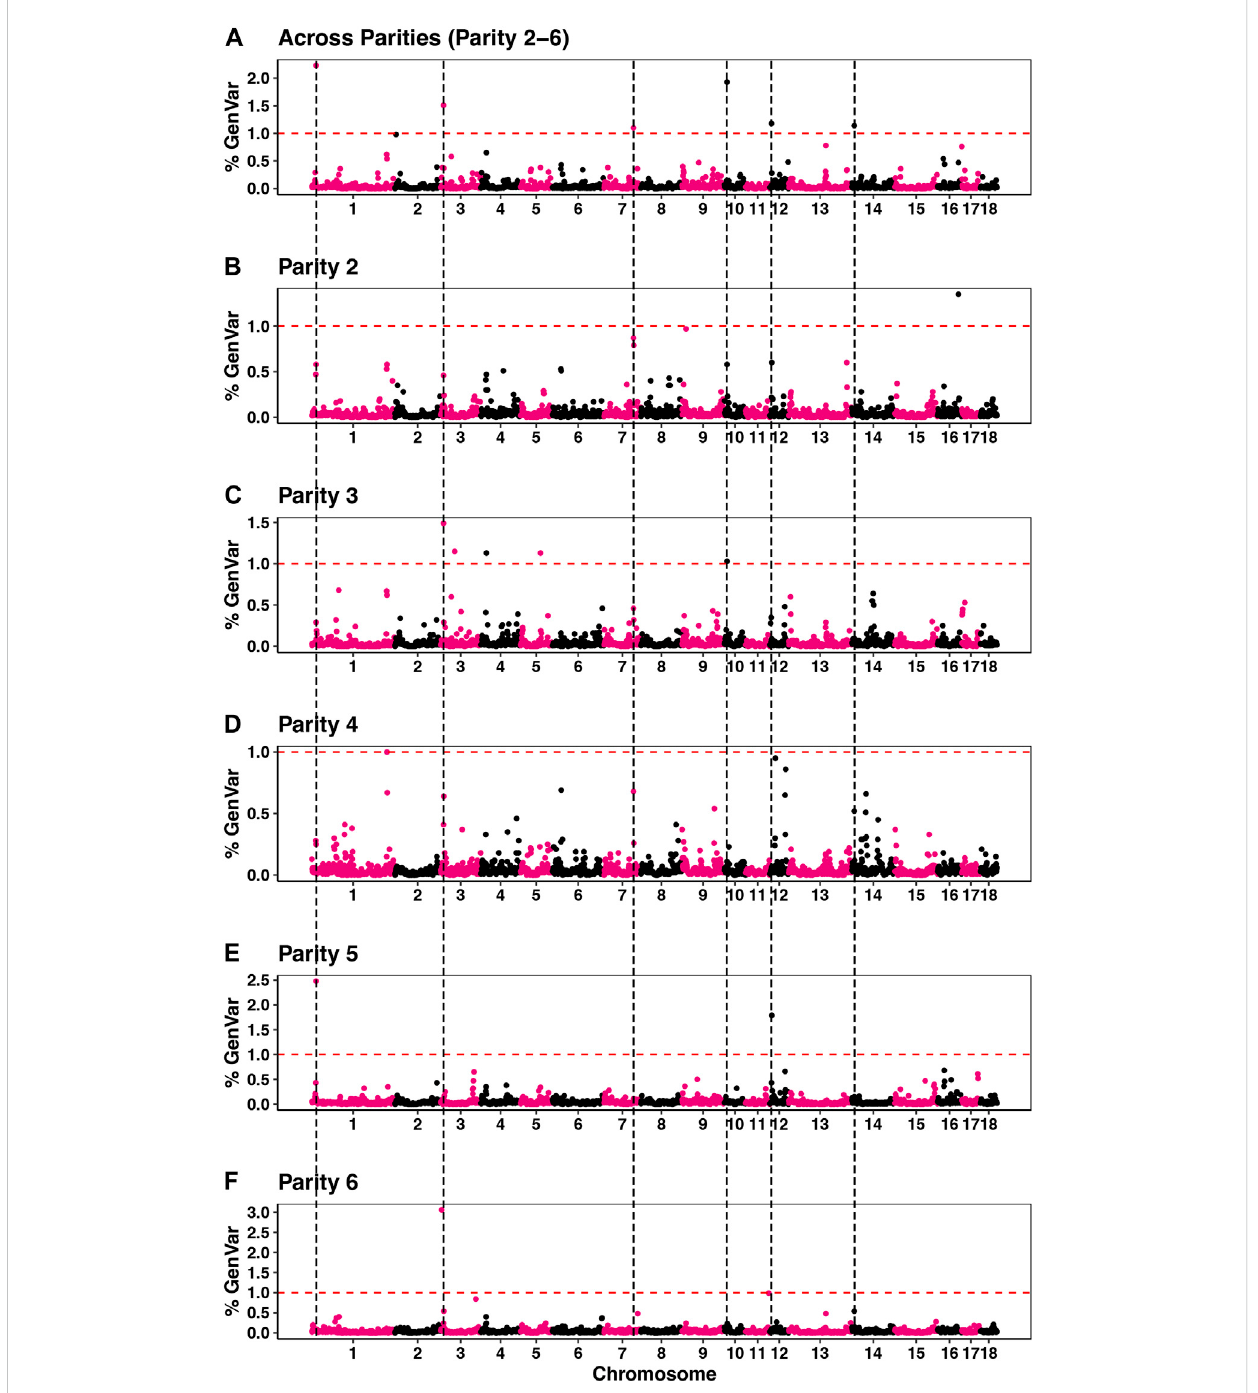
FIGURE 3 Percentageofgeneticvarianceexplainedbynon-overlapping1 Mbwindowsacrossthegenomefortheacross-parity (A) andby-parity (B – F) Bayes- B analyses. Windows (above the red dash line) were considered signi fi cant (explained > 1% of genetic variance) and the black dashed lines identi fi es signi fi cant windows based on the across-parity